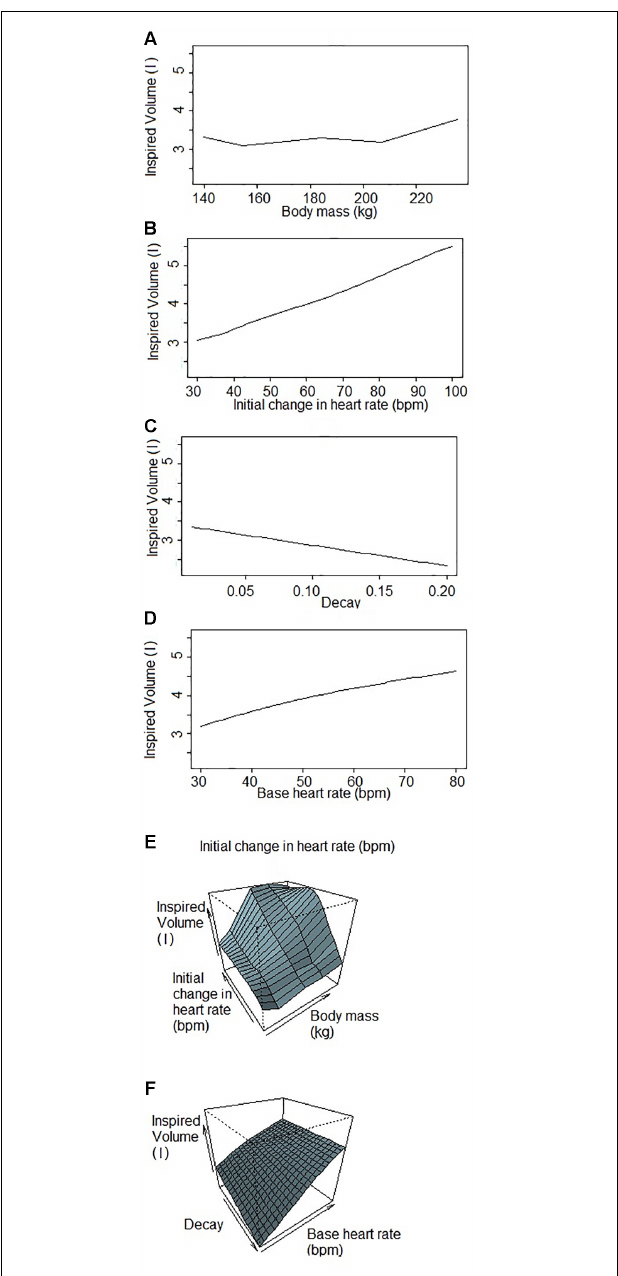
FIGURE 3 | Sensitivity analysis of each variable used to predict inspired tidal volume by the Generalized Additive Model when one (or two) factor(s) changes while others are fixed. Inspired volumes are in liters. (A) Inspired volume as a function of body mass. (B) Inspired volume as a function of the initial change in heart rate. The initial jump is the parameter of the GAM that explains the most variation in inspired volume of the four parameters. (C) Inspired volume as a function of the decay. The decay is the parameter that explains the lowest variation in the GAM. (D) Inspired volume as a function of the base heart rate. The base heart rate is the variable that has the second most influence on the inspired volume predicted by the GAM. (E,F) Inspired volume as a function of two parameters (E) body mass and initial change in heart rate; (F) decay and base heart rate. These figures illustrate the covariance of the parameters that have consequences for the predicted inspired